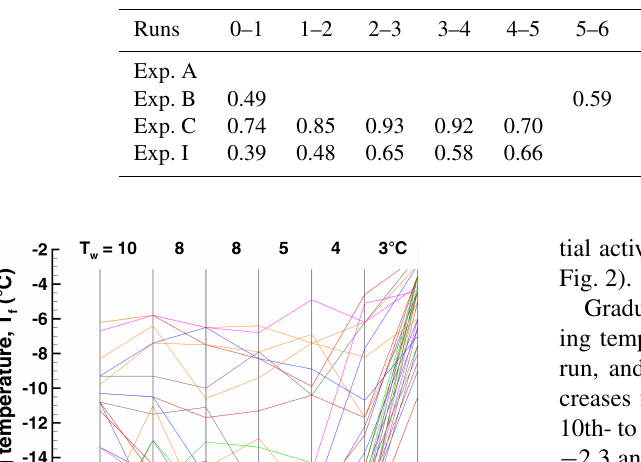
Table 3. Correlation coefficients for selected pairs of runs. Values with an asterisk are for runs involving PFN.